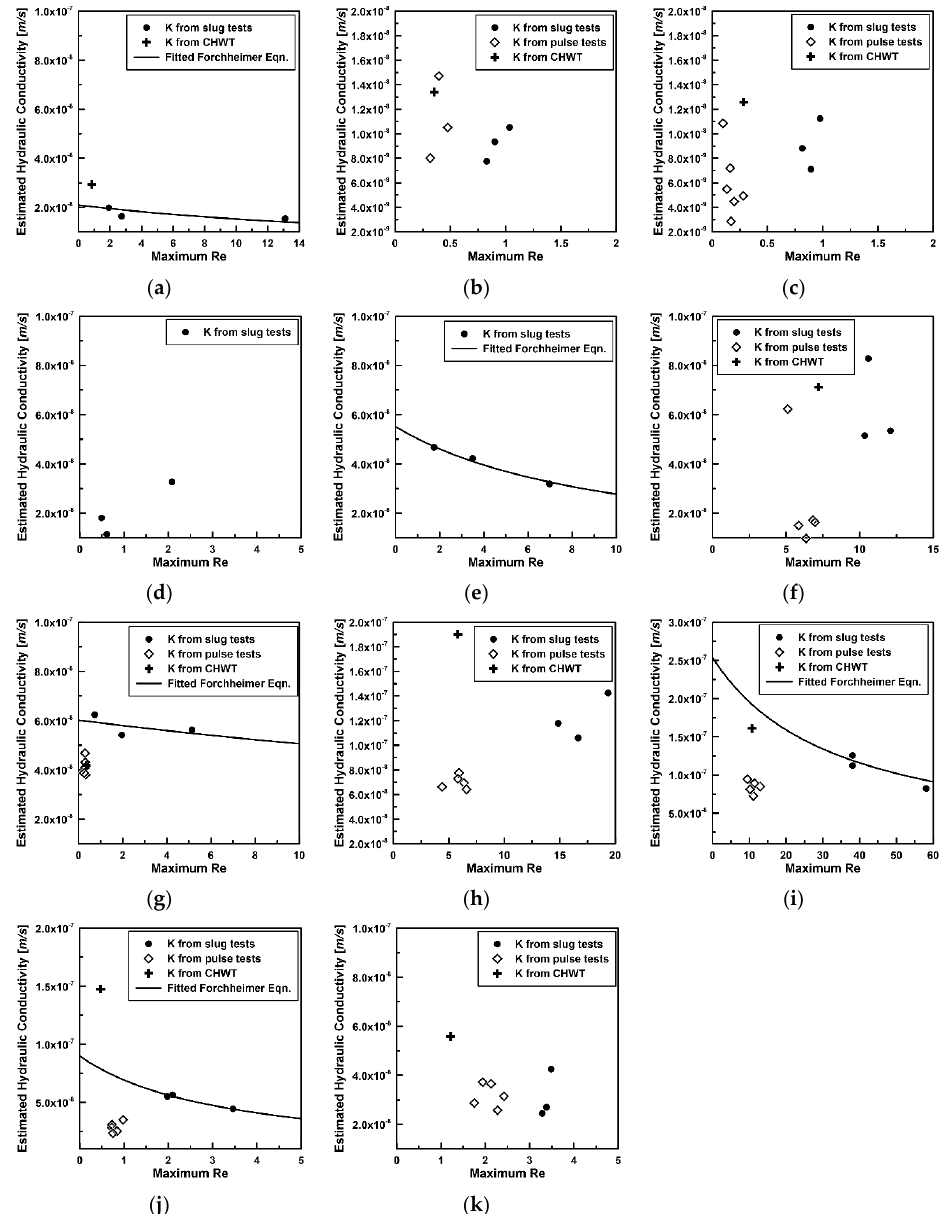
Figure 5. Relation between the estimated K and maximum Re at ( a ) section 1; ( b ) section 3; ( c ) section 4; ( d ) section 5; ( e ) section 6; ( f ) section 7; ( g ) section 8; ( h ) section 9; ( i ) section 10; ( j ) section 11; and ( k ) section 12. The solid and dashed lines are the fitted curves using Equation (7) to evaluate the influence of nonlinear flow on the tests and discuss distortion of the estimated 𝐾 from the tests.